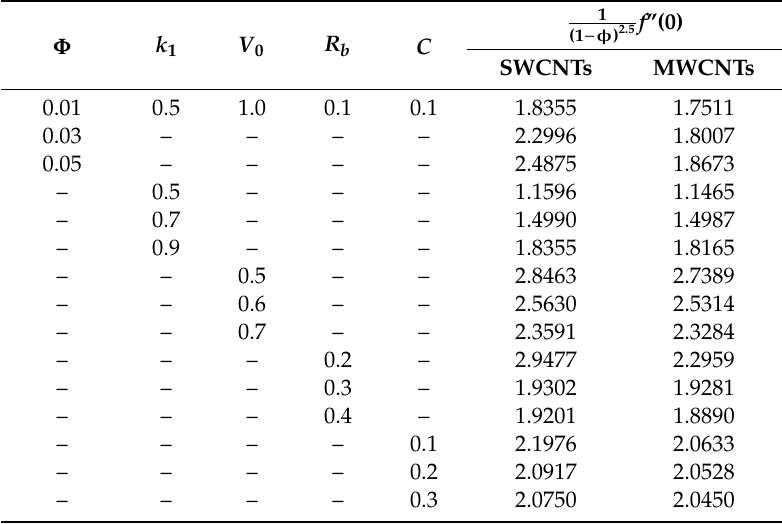
Table 3. Estimations of skin friction f (cid:48)(cid:48) ( 0 ) versus di ff erent evaluations of various parameters.